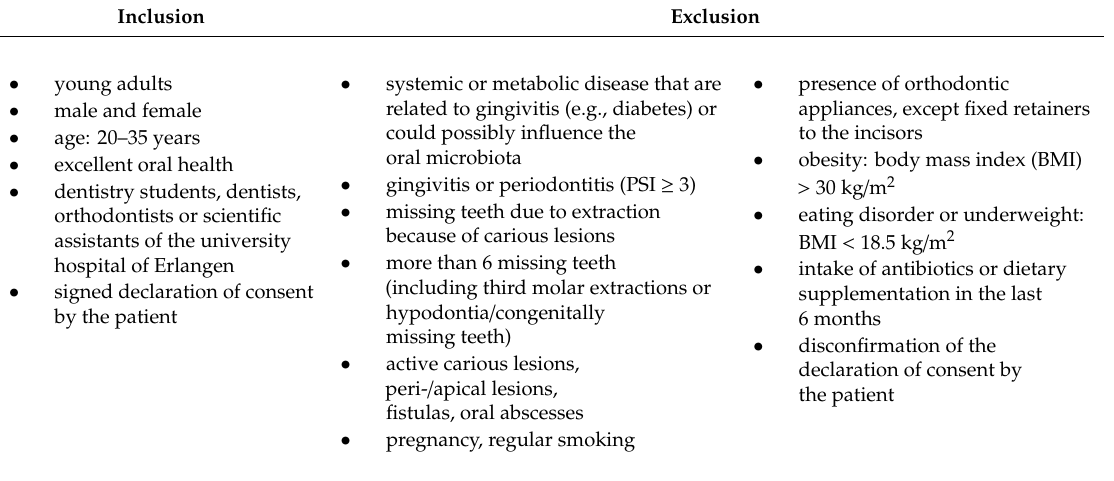
Table 1. List of inclusion and exclusion criteria for subject enrolment in the clinical